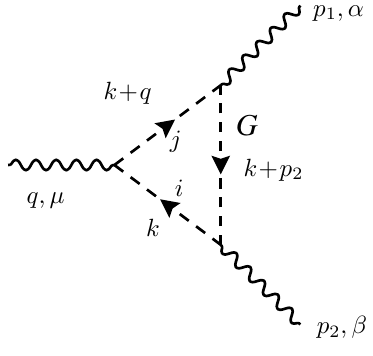
0 in the loop. (cid:22)(cid:11)(cid:12) with h i ; h j ; G